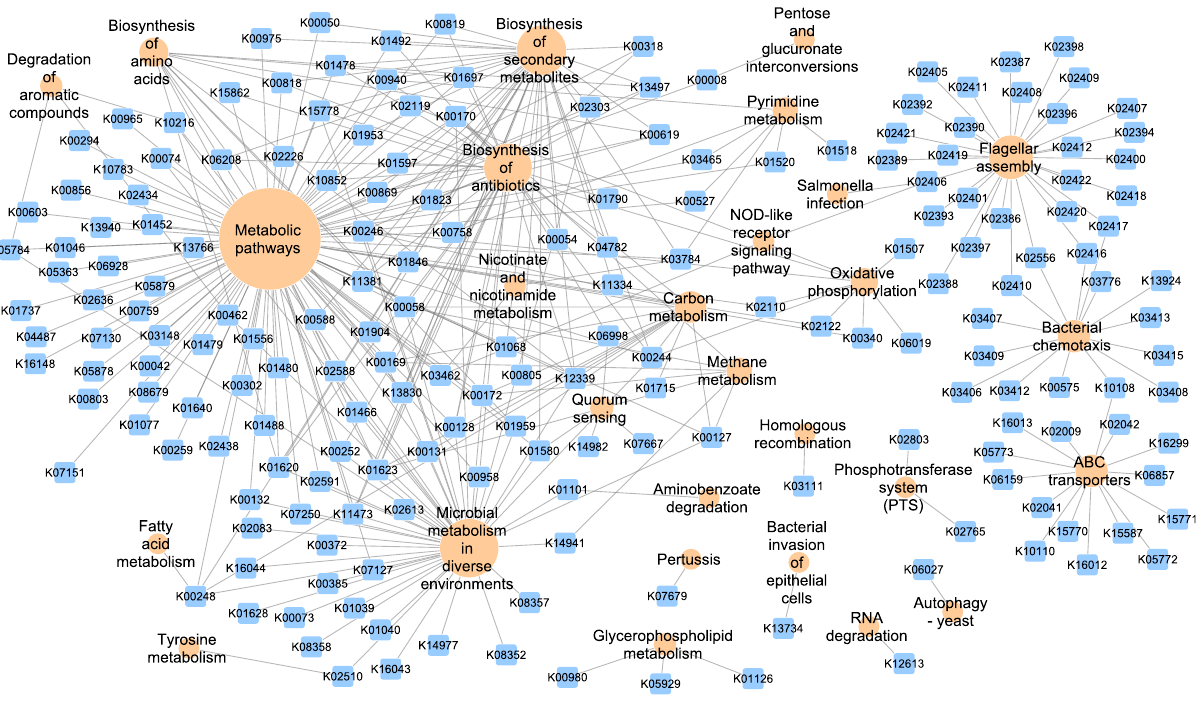
Figure 4. Up-regulated tongue-coating microbial genes and enriched pathways. Blue nodes represent KEGG KOs, and yellow nodes represent KEGG pathways. The edge between two nodes indicates that the gene was in the pathway. The size of the yellow node is proportional to the connection degree, i.e., pathways with a higher number of up-regulated genes exhibit